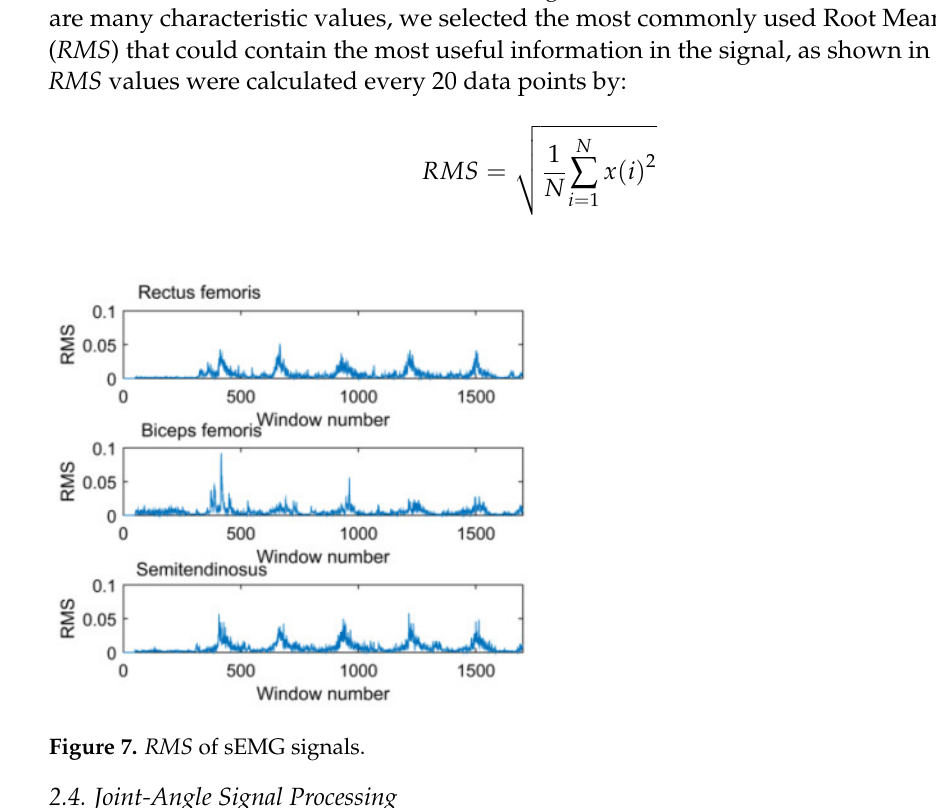
Figure 7. RMS of sEMG signals.